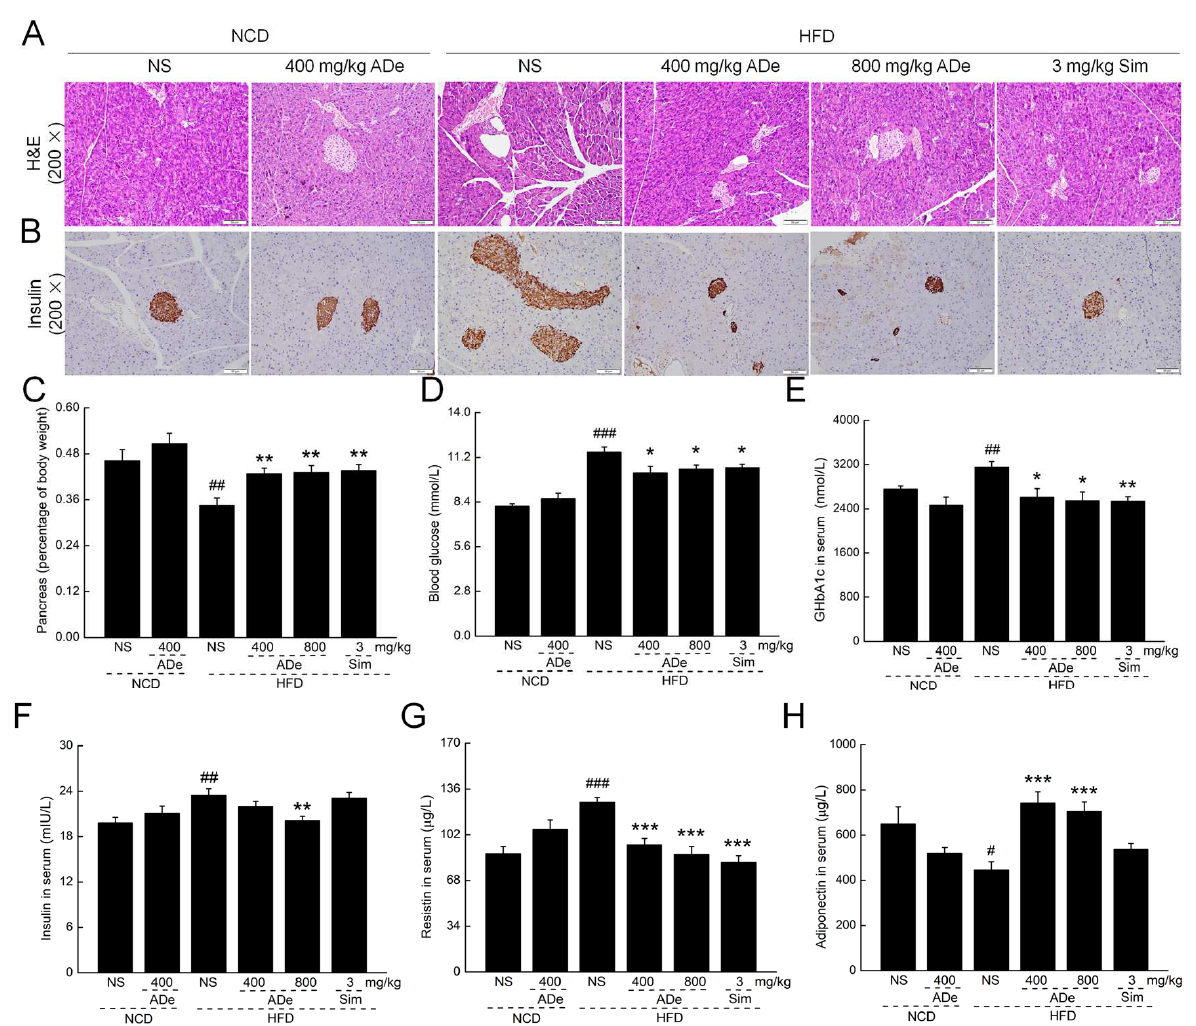
Figure 3. Effect of ADe treatment on pancreatic function. ( A ) Histopathological analysis of the pancreas using H&E staining (200 × ; scale bar: 50 µ m). ( B ) ADe reduced pancreatic insulin levels (200 × ; scale bar: 50 µ m) as analyzed via immunohistochemistry. ADe treatment increased ( C ) the pancreas index, decreased ( D ) the blood glucose, ( E ) GHbA1c, ( F ) insulin, and ( G ) resistin levels, and increased serum ( H ) adiponectin levels (n = 6). # p < 0.05, ## p < 0.01, and ### p < 0.001 versus NCD-fed mice; * p < 0.05, ** p < 0.01, and *** p < 0.001 versus HFD-fed mice.